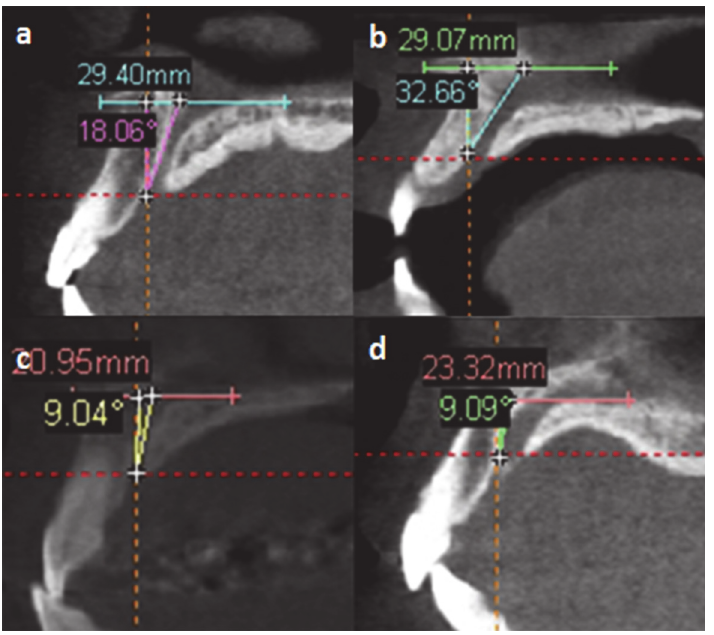
doi:10.1371/journal.pone.0117251.g004